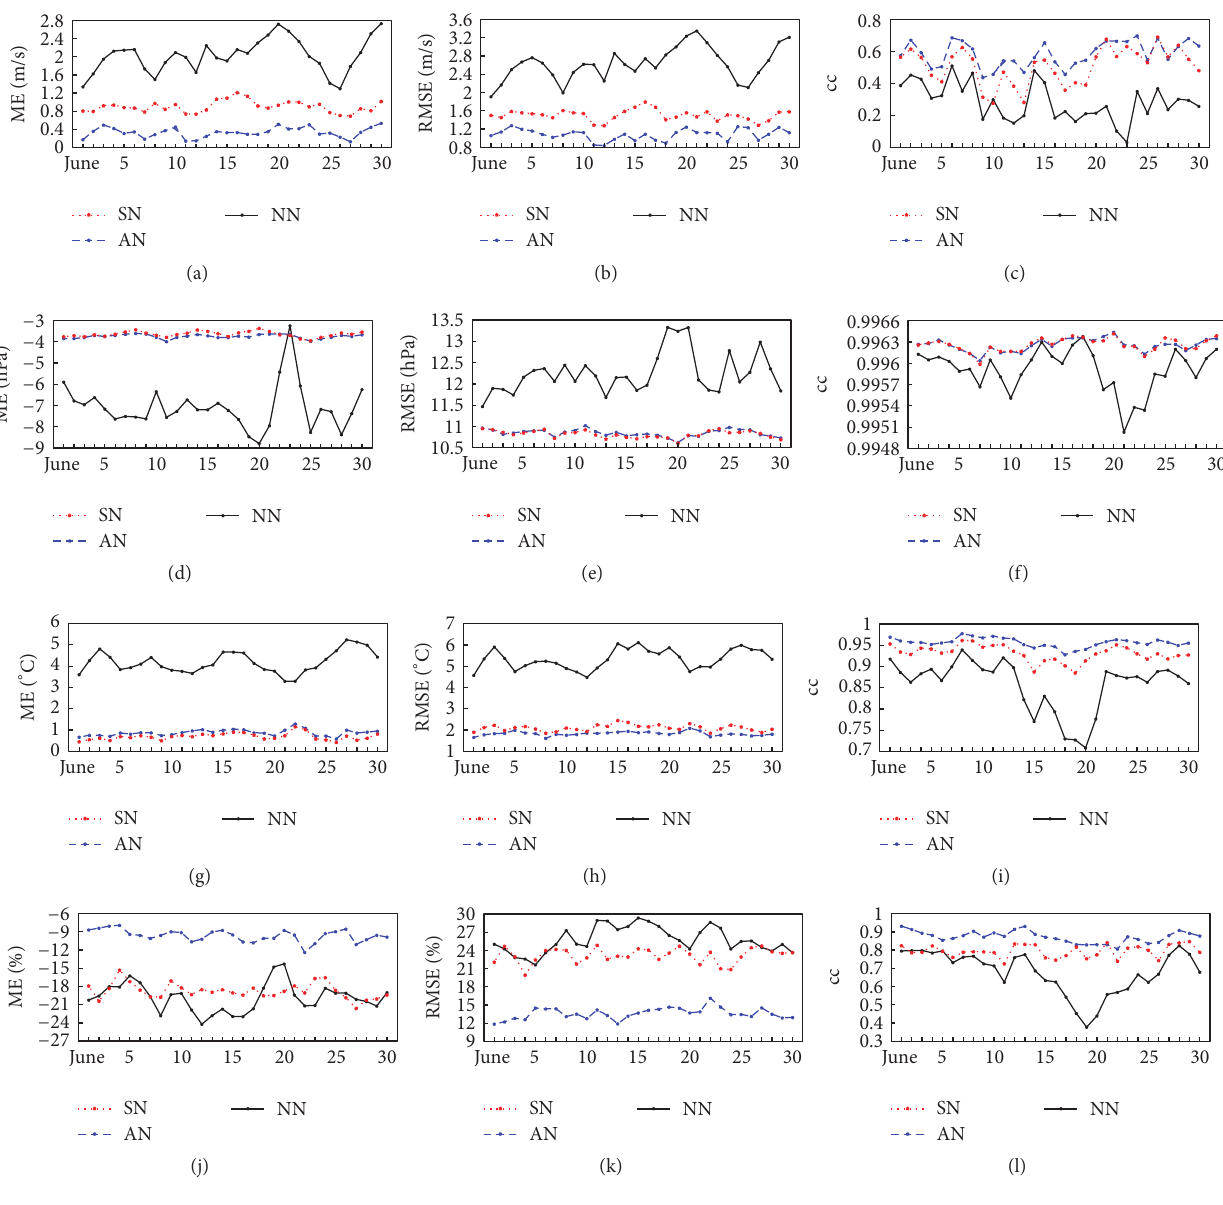
Figure 7: The same as Figure 6 but for June,